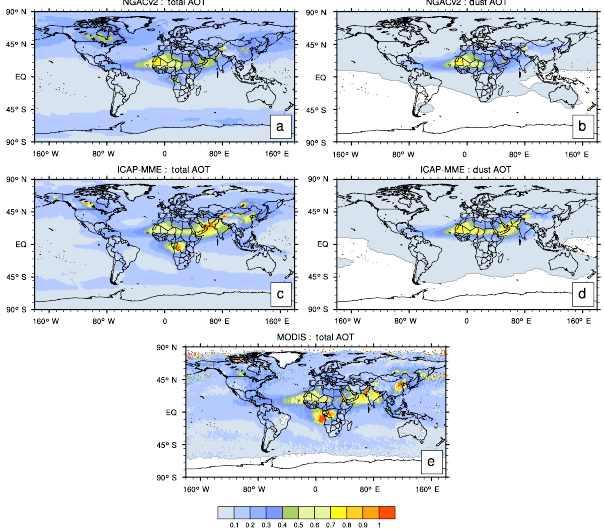
Figure 1. Global maps of averaged AOT 550nm for JJA (June– July–August) 2015. Total AOT from NGACv2, ICAP and MODIS are in (a, c, e) ; NGACv2 dust-only is in (b) , and ICAP dust-only is in (d) . NGAC, ICAP and MODIS AOT 550nm are at 1 ◦ resolution. Values beyond the range of the color bar are represented by the end